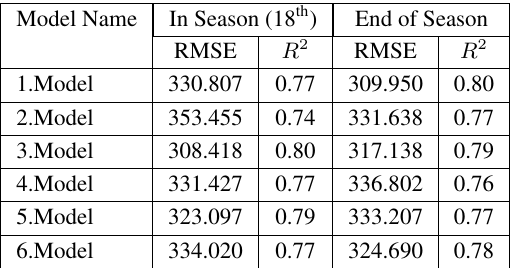
Table 6. 5-fold cross validation results of HistCNN model.